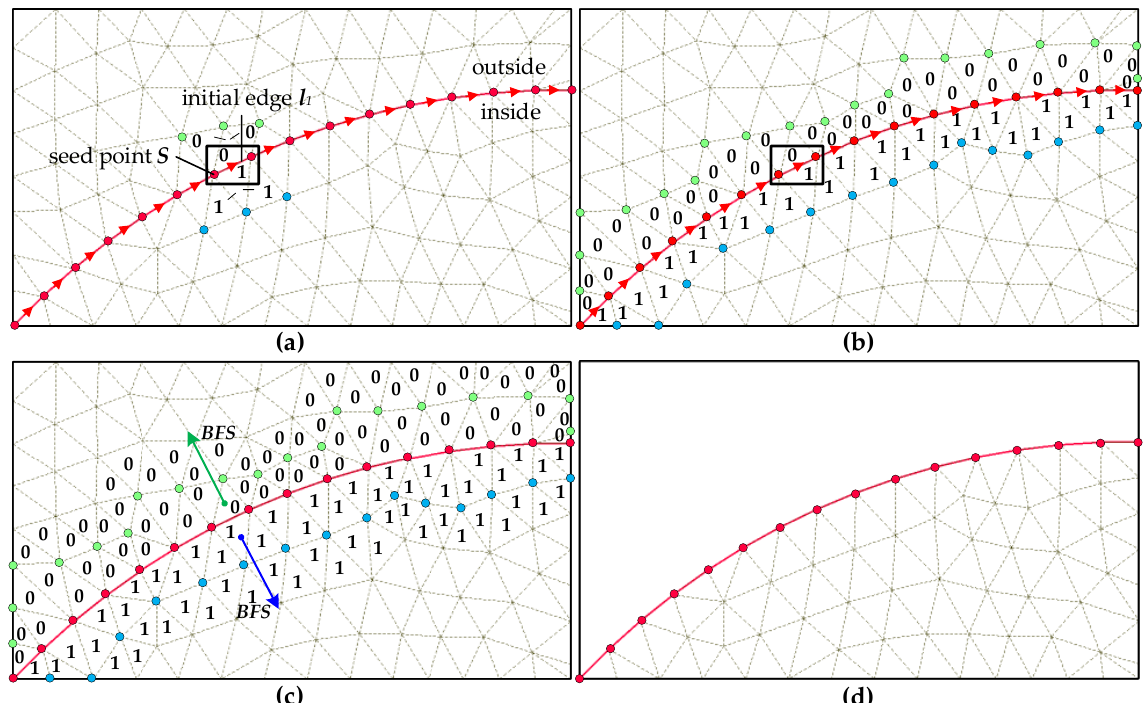
Figure 9. Mesh boundary clipping process. ( a ) shows the selection of seed points and initial edges on the boundary polyline and the marking of triangular patches adjacent to the initial edges. ( b ) shows the result of marking the triangular patches adjacent to the whole boundary polyline. ( c ) shows the result of marking all triangular patches based on the marked triangular patches. ( d ) shows the result of deleting all triangular patches with a label value of 0.